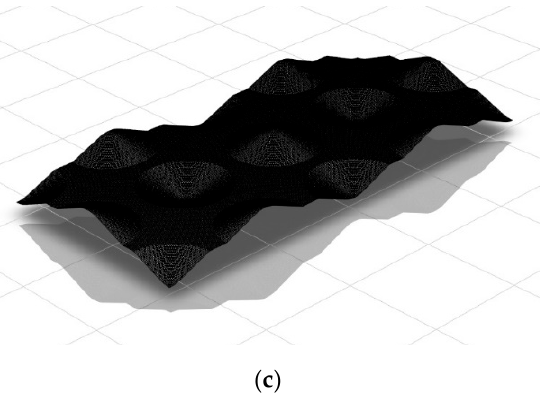
Figure 4. Three levels of the surface roughness model: ( a ) H = 60 μm ; ( b ) H = 40 μm and ( c ) H = 20 μm .